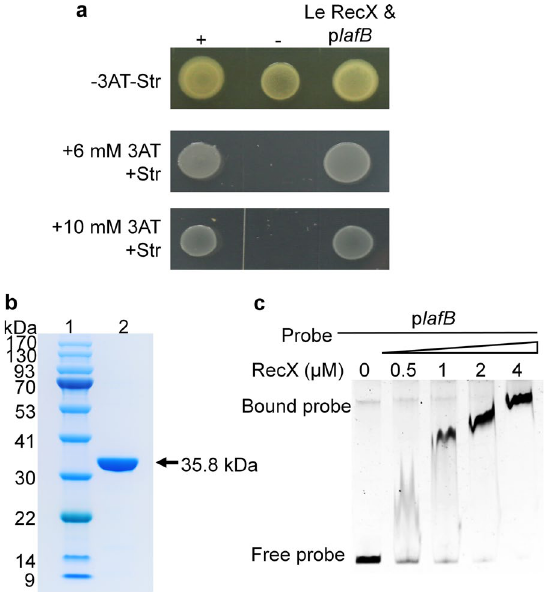
Fig. 5 RecX directly bound the promoter of the HSAF biosynthesis gene (p lafB ). a Direct physical interaction between RecX and the lafB promoter region was detected in E. coli . Experiments were performed according to the procedures described in the ‘Experimental procedures’ section. , cotransformant containing pBX-R2031 and + pTRG-R3133, used as a positive control; , cotransformant containing − pBXcmT-p lafB and the empty pTRG, used as a negative control; L. enzymogenes RecX and p lafB , cotransformant harboring pTRG-RecX and pBXcmT-p lafB . -3AT-Str, plate with no selective medium (3AT 3-amino-1,2,4-triazole and Str streptomycin) and 3AT Str, plate + + with M9-based selective medium. b The purified protein was analyzed by 12% SDS-PAGE. Lane 1, molecular mass markers; Lane 2, RecX protein. c Gel shift assay showing that RecX directly bound p lafB . RecX (0, 0.5, 1, 2, or 4 μM) was added to reaction mixtures containing 50 ng of probe DNA, and the reaction mixtures